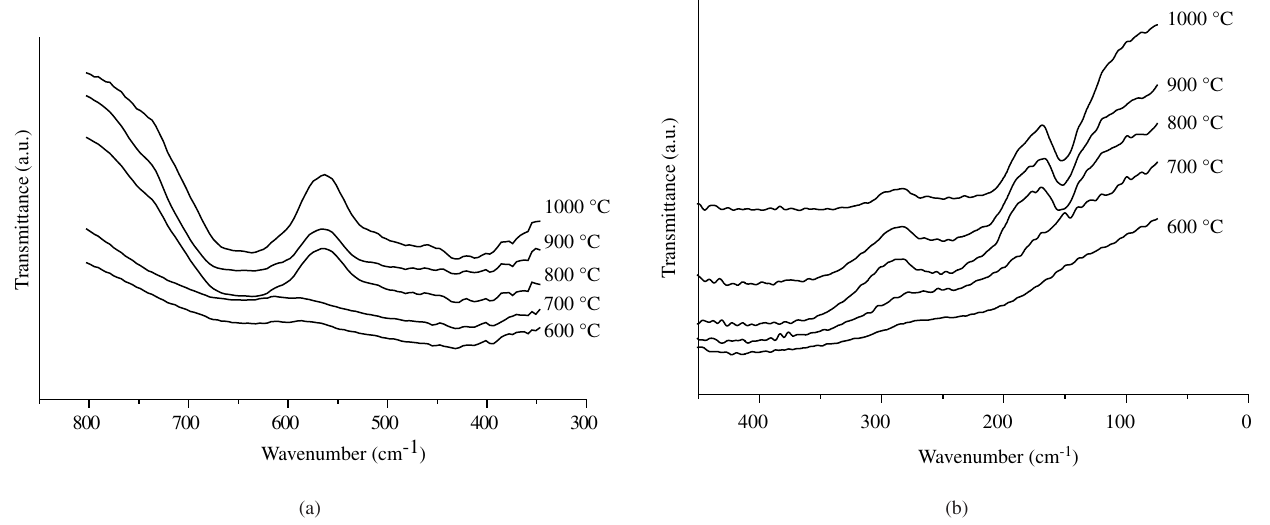
Figure 10. Infrared spectrum of the sample Zn 100 cm -1 .